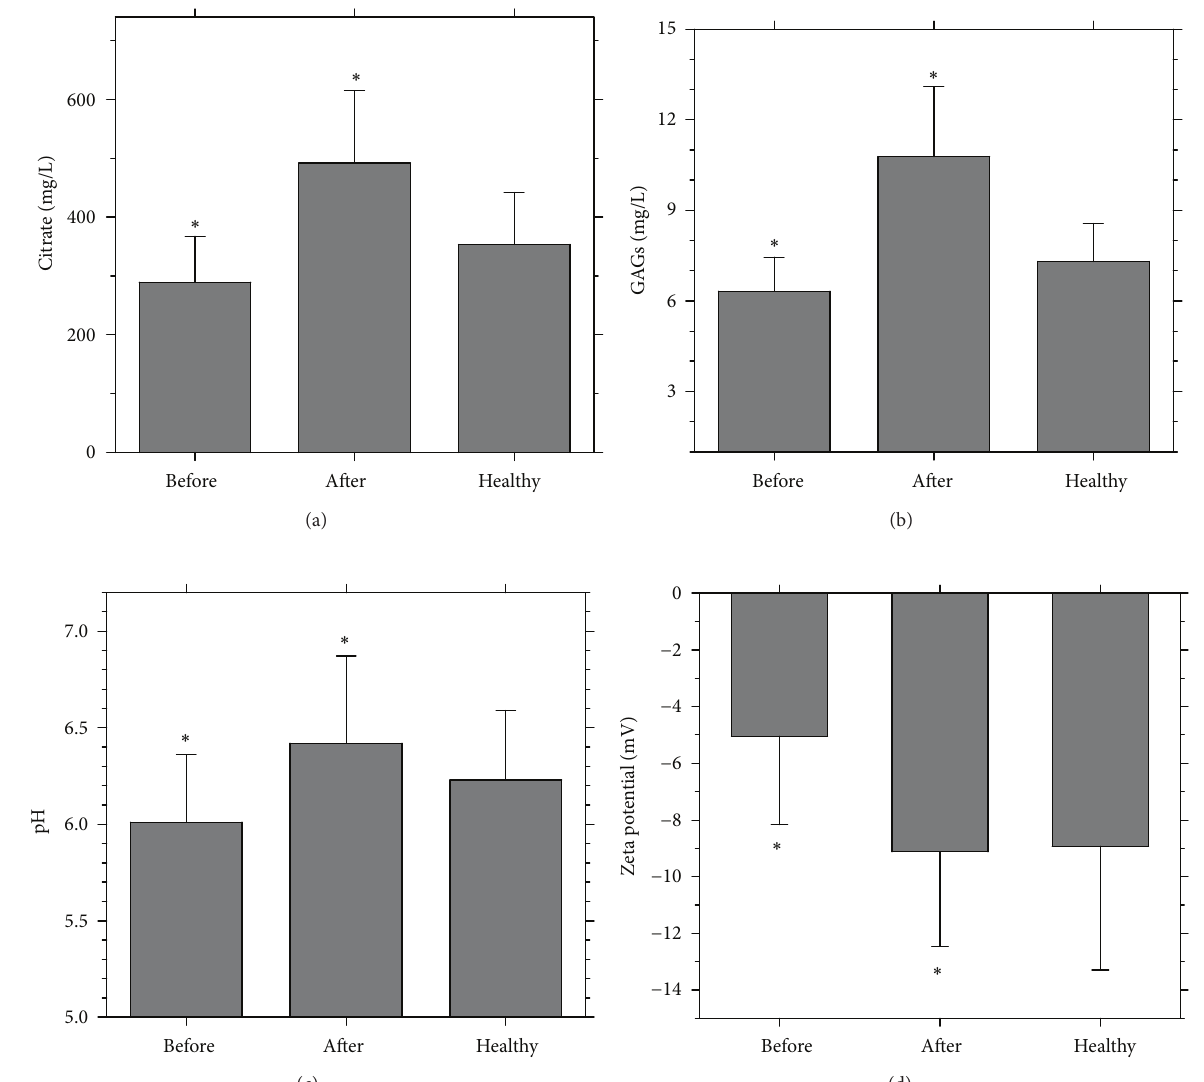
Figure 4: Comparison between the properties of urine and urinary crystals from healthy control individuals and patients with CaOx calculi before and after K 3 cit intake. (a) Excretion amount of citrate; (b) excretion amount of GAGs; (c) urinary pH; (d) zeta potential ( 𝑛 = 30